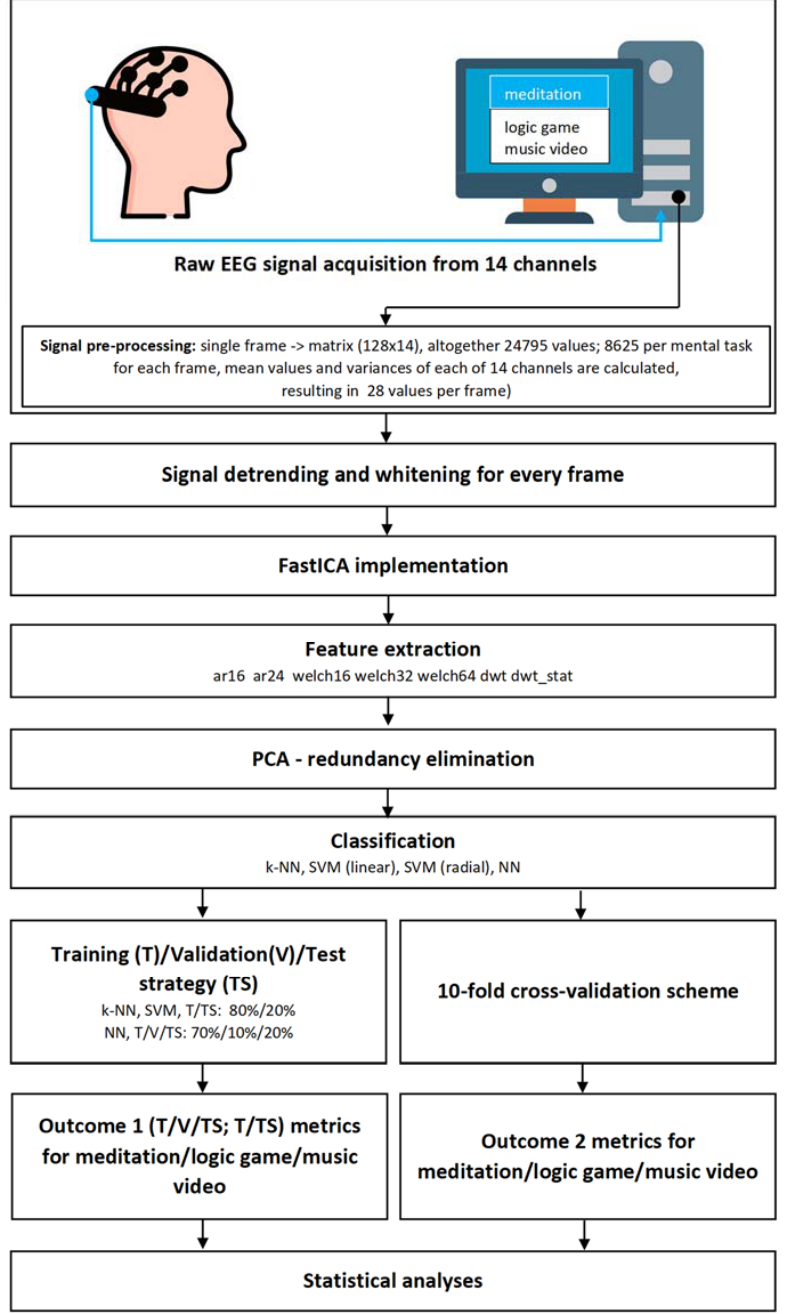
Figure 1. The flowchart of the study performed.